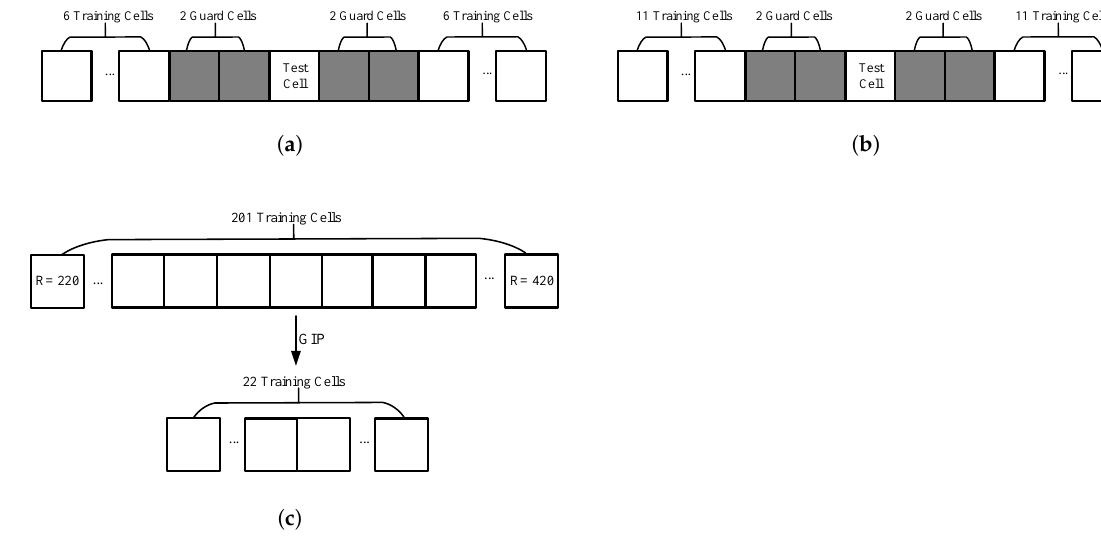
Figure 8. Training data selection: ( a ) first test case, ( b ) second test case, and ( c ) third test case.